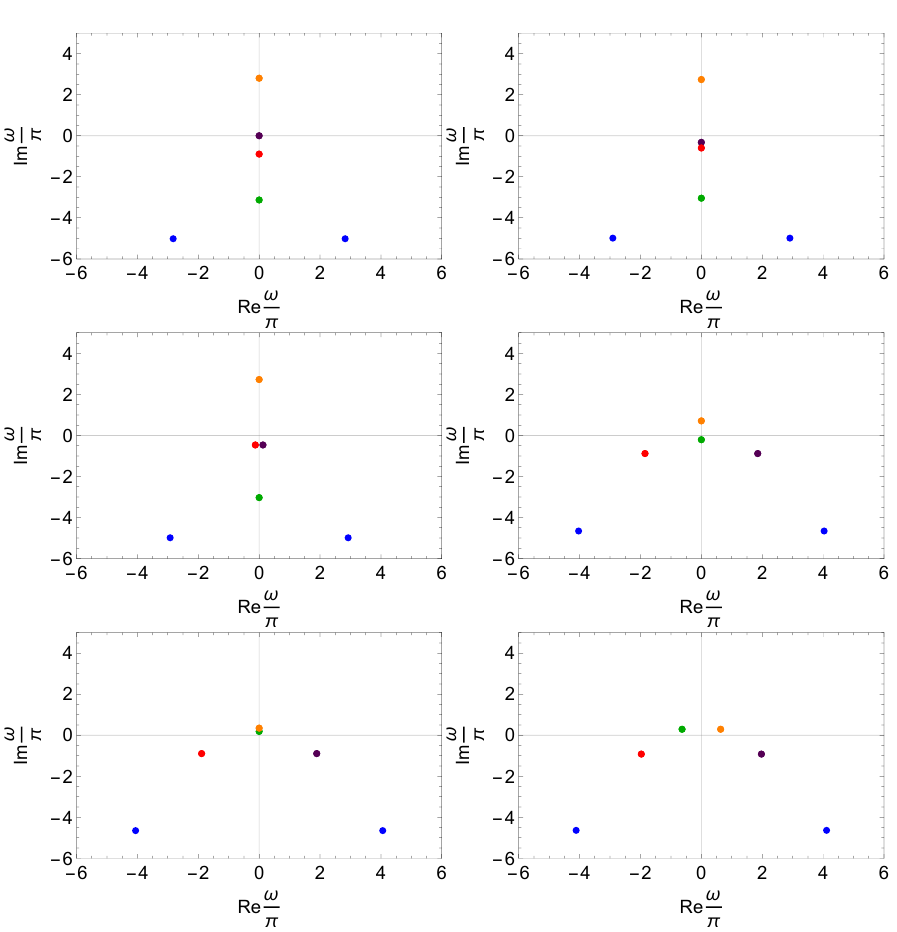
Figure 5. The first 6 poles in the complex plane for k = { 0 , 0 . 554 π, 0 . 6 π, 2 . 4 π, 2 . 4334 π, 2 . 54 π } (from √ T = 0 . 35. We distinguish the di ff erent poles via the following colors top left to bottom right), for β di ff usion pole, quasi-hydro pole, transient unstable mode, semiholographic pole and holographic